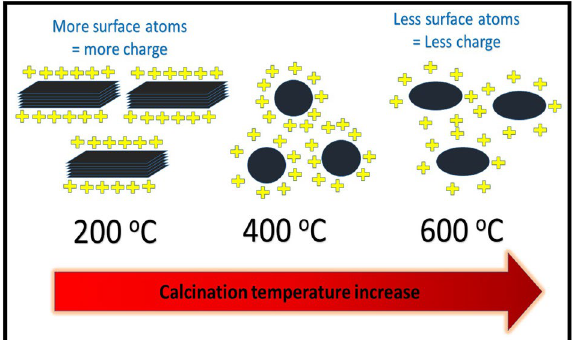
Figure 5. Explanation of the mechanism of zeta potential decrease with calcination